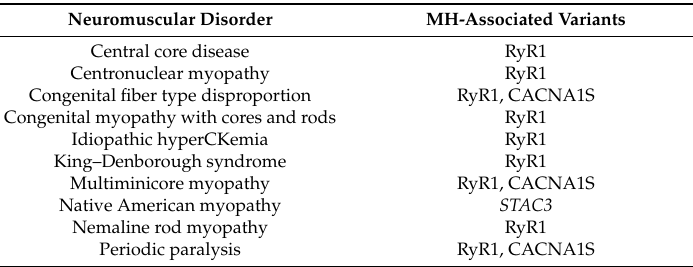
MH: malignant hyperthermia, RyR1: ryanodine receptor, CACNA1S: RyR1-activating protein, CK: creatinine